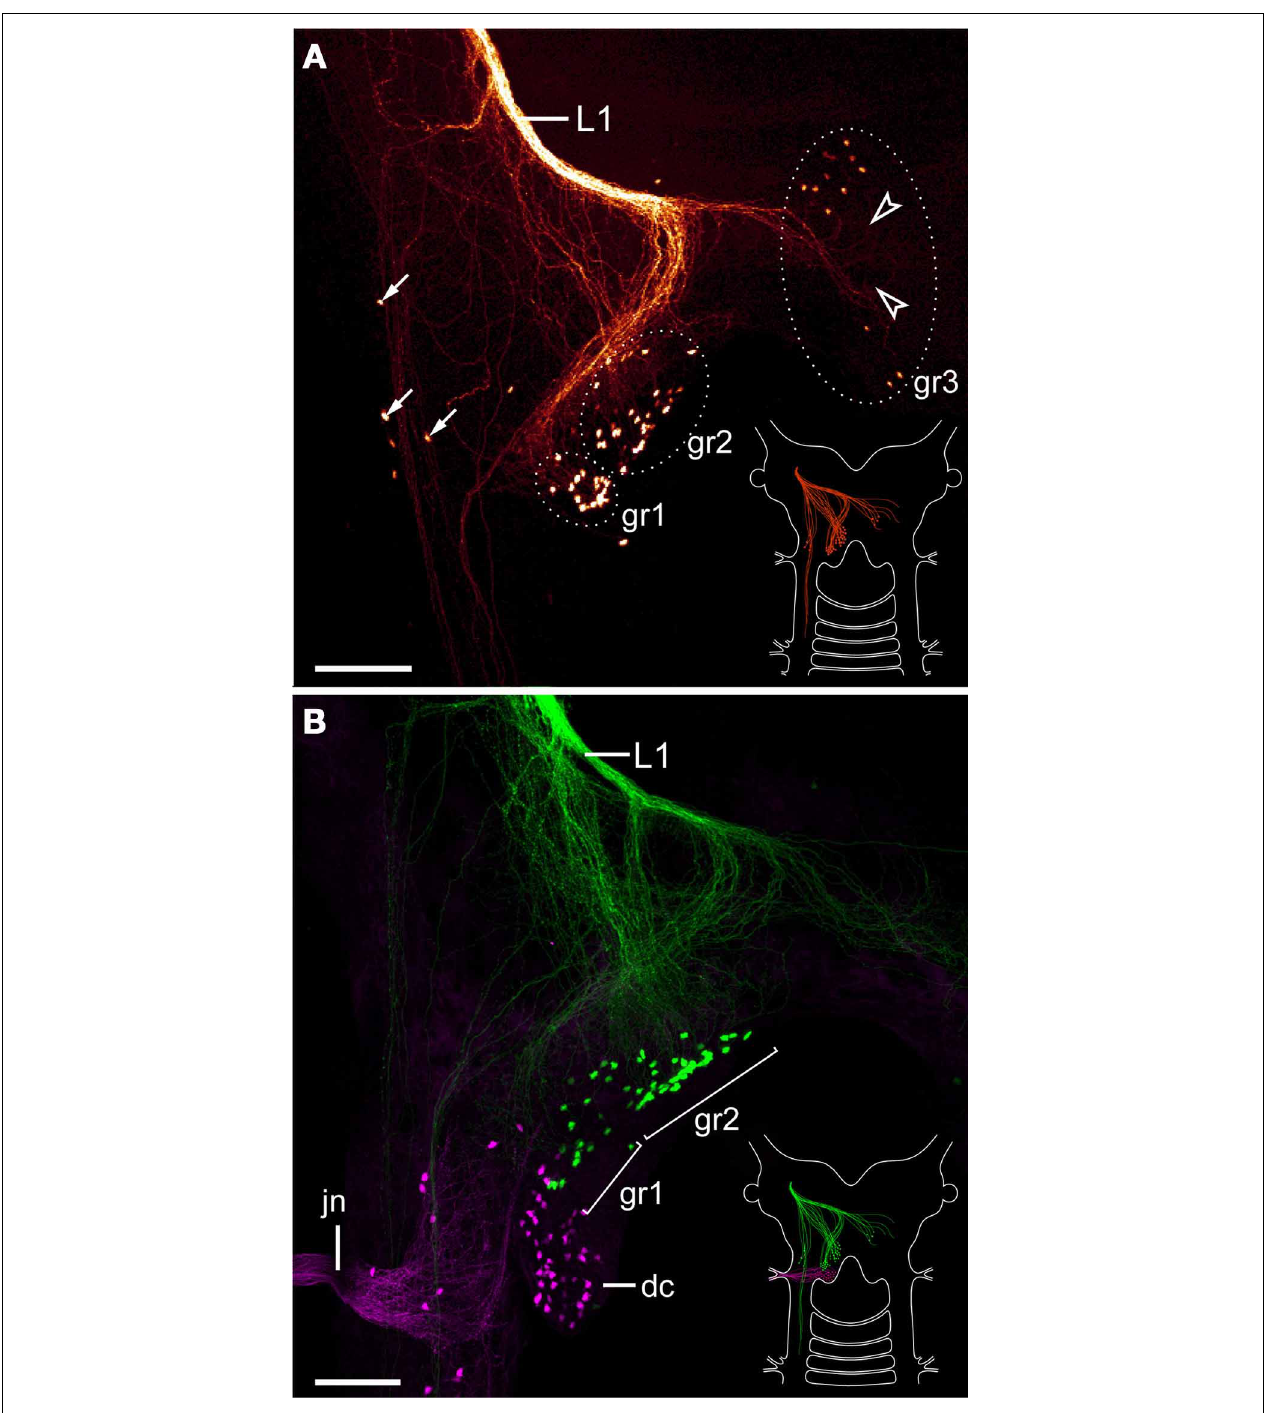
FIGURE 6 | Localization of neuronal somata associated with the first lip papillae nerve in Euperipatoides rowelli . Maximum projection confocal micrographs. Anterior is up in all images. (A) Retrograde fill of the first lip papillae nerve (L1) with dextran coupled to tetramethylrhodamine (glow mode). Note the position of neuronal somata in the posterior portion of the brain, a few additional lateral somata (arrows), and numerous fiber endings that are not associated with any somata (arrowheads). Diagram in the lower right corner illustrates the position of labeled somata and fibers in the brain. (B) Double-fill of the first lip papillae nerve with dextran coupled to